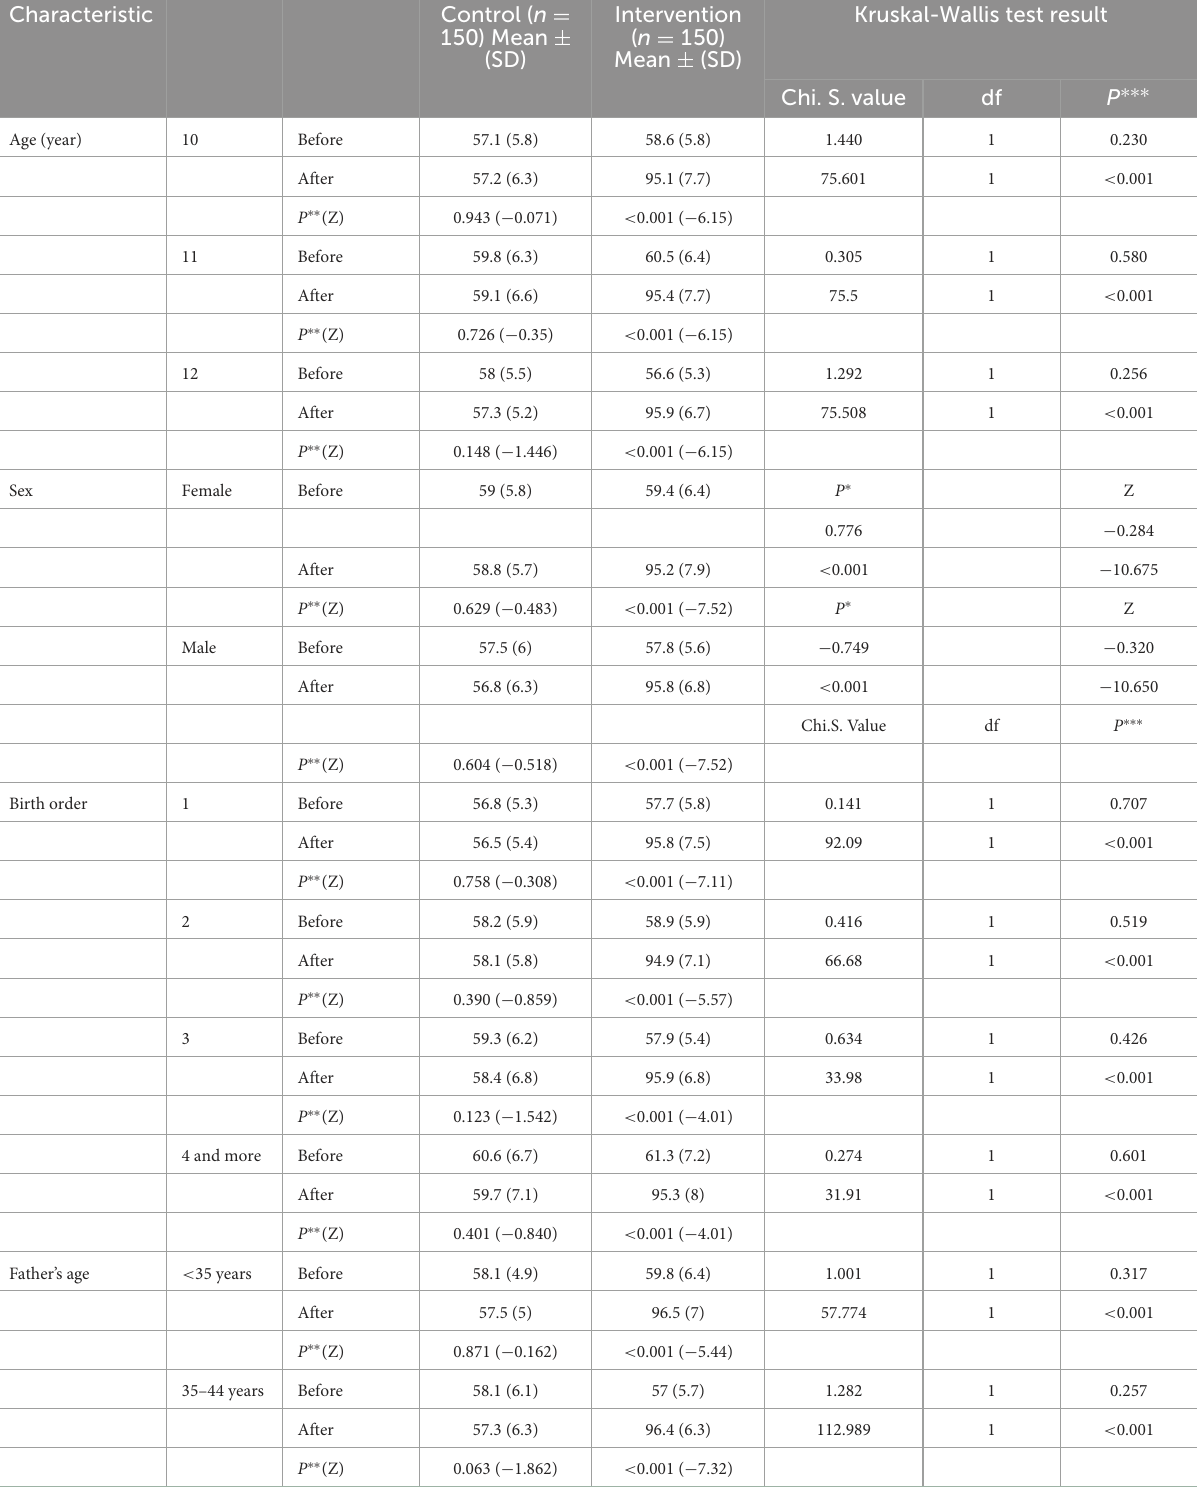
TABLE 4 Comparison of FNLIT scores based on the demographic and social characteristics in both groups before and after the intervention.